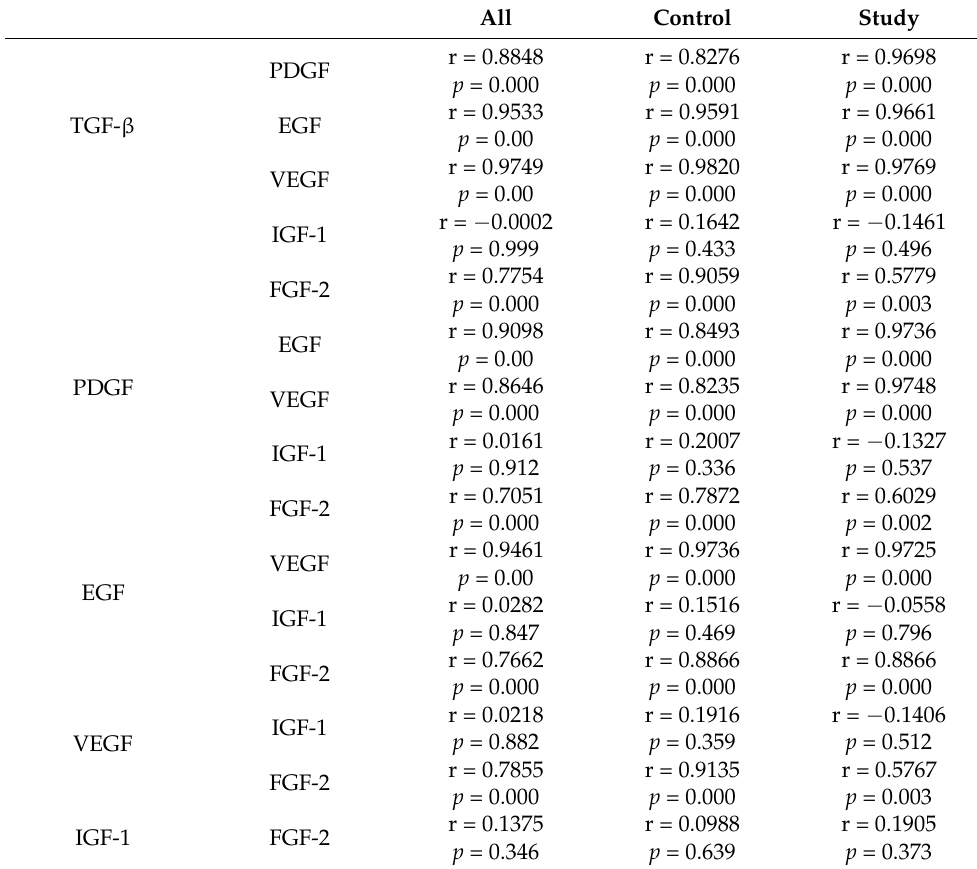
Table 5. Pearson correlation between